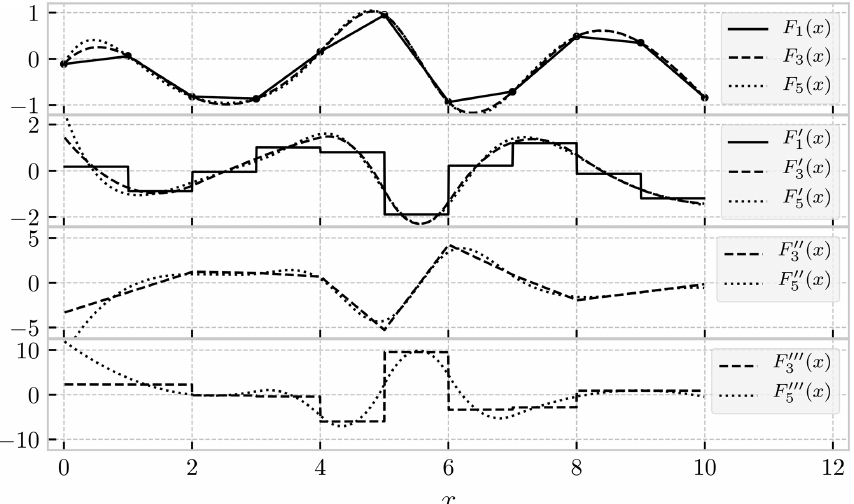
Figure 1. One-dimensional illustration of different degrees of interpolation. From the same 11 data points (shown as black circles in the top panel), we have constructed a linear interpolation (continuous lines), a cubic spline interpolation (dashed lines), and a quintic spline interpolation (dotted lines). From the top, the panels show the interpolated functions, the first derivative, the second derivative, and the third derivative. We observe that linear interpolation, F 1 (x) , gives a discontinuous derivative, and cubic interpolation, F 3 (x) , gives a discontinuous third derivative.